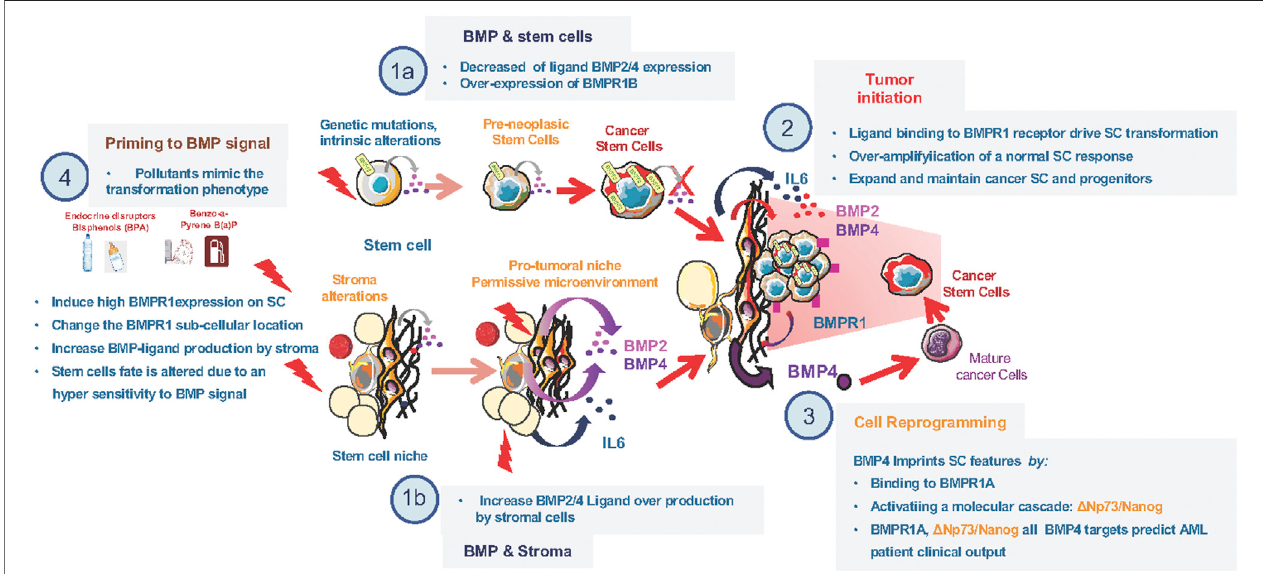
FIGURE 1 | Alterations of the BMP pathway involved in early steps of transformation. (1a) Decrease in ligand (BMP2 and/or BMP4) and increase in type1 BMP- receptor at time of diagnosis in stem cells of diferent leukemia and breast cancer types. (1b) Increase in ligand (BMP2 and/or BMP4) production by stromal cells of the tumor microenvironement at time of diagnosis in diferent leukemia and breast cancer types. (2) Cooperation between BMP2 overproduction by the stroma and IL6 to induce BMPR1b overexpressing stem-cells transformation. (3) BMP4 mediated reprogrammation of mature cells toward an imature stem-like cell. (4) Effect of environmental polluant on the expression of both ligand and BMPR1 expression in healthy cells.